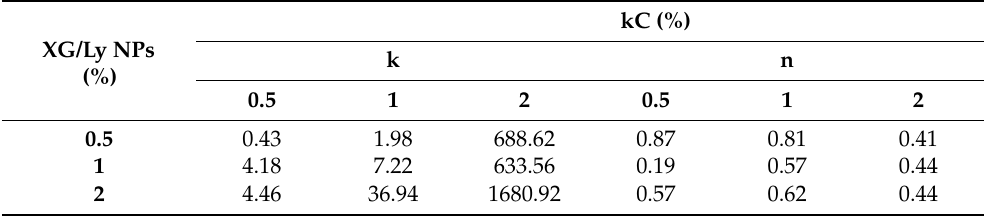
Table 2. Power law modelling parameters of frequency dependent behavior for emulsion gels.